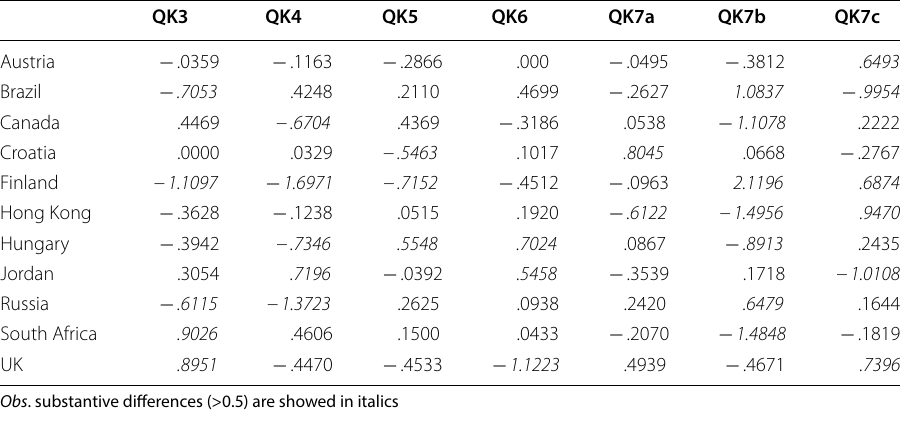
Table 8 DIF size illustration across all countries